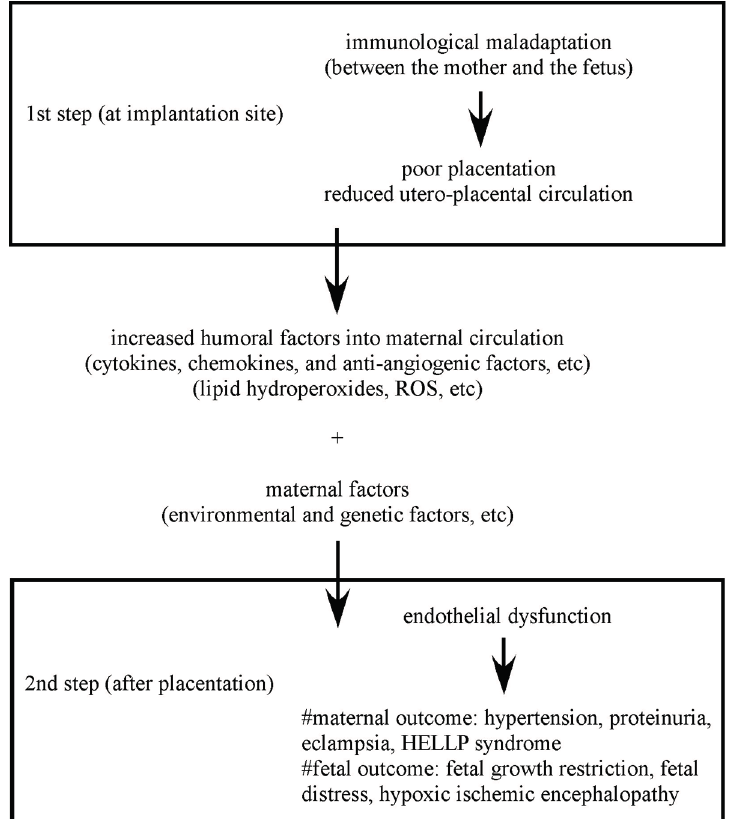
Figure 1. Two-step theory in the pathogenesis of preeclampsia (PE). Immunological maladaptation causes poor placentation leading to placental hypoxia at the first step. Hypoxic placenta induces the production and secretion of humoral factors into maternal systemic circulation. These factors disturb vascular endothelial function resulting in multiple organ failure at the second step. (This figure is modified from